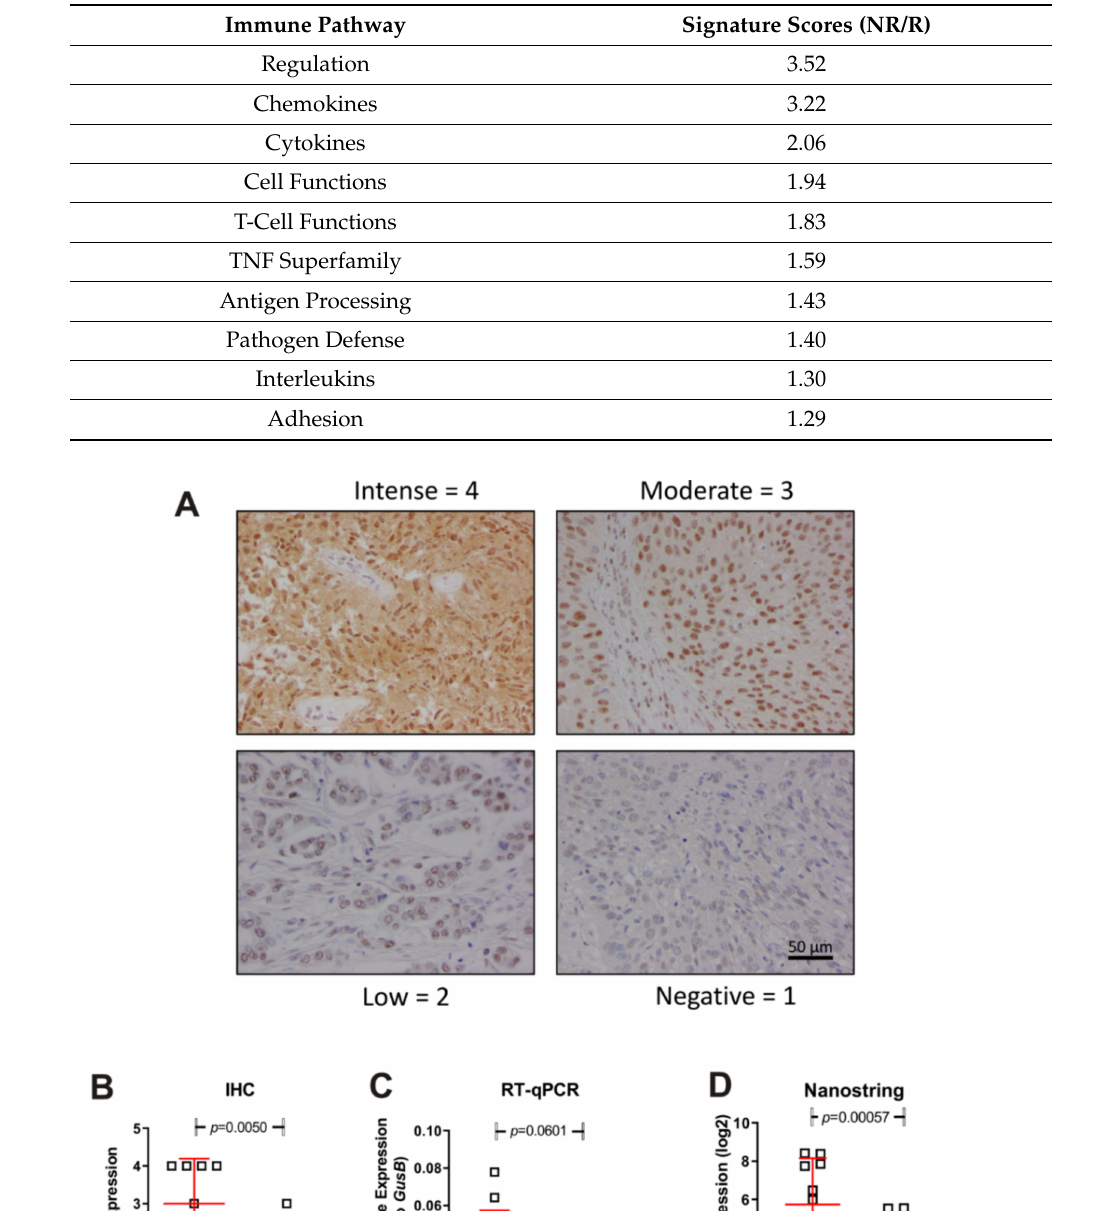
Table 3. Enrichment in Immune-related pathways between R and NR Patients.